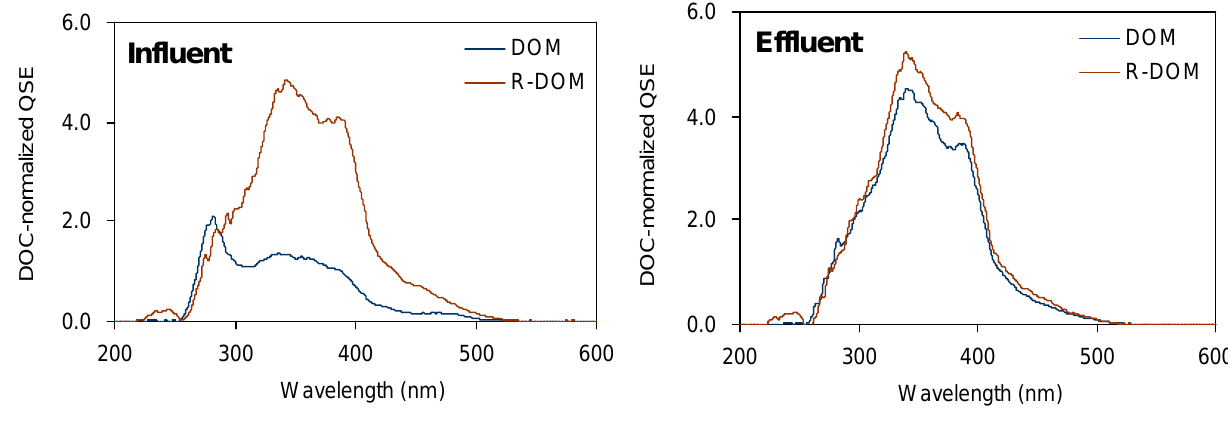
Figure 2. Synchronous fluorescence spectra of influent and effluent sewage from the wastewater treatment plant (DOM: dissolved organic matters, R-DOM: refractory dissolved organic